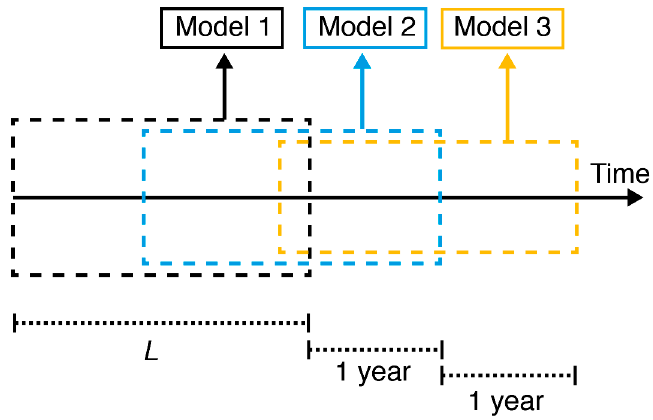
Figure C1. Schematic drawing of the SLR approach. L denotes the window length.